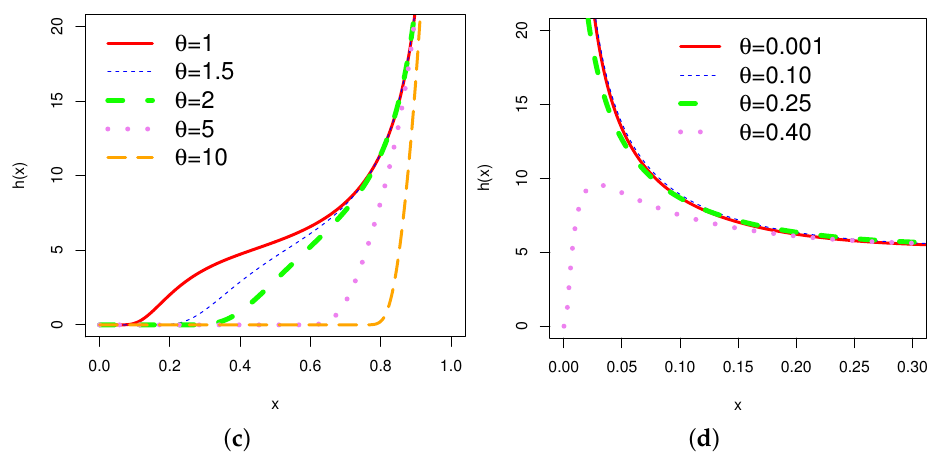
Figure 2. Plots of various shapes of the hrf of the UTD for varying values of the parameter θ . The graphs of the hrf for various combinations of parameters show various shapes, including increasing, decreasing, bathtub, and N-shaped (modified bathtub shape). Ac- cording to [29], mortality among breast cancer patients is characterized by an N-shaped hrf. This is one of the prominent properties of the UTD